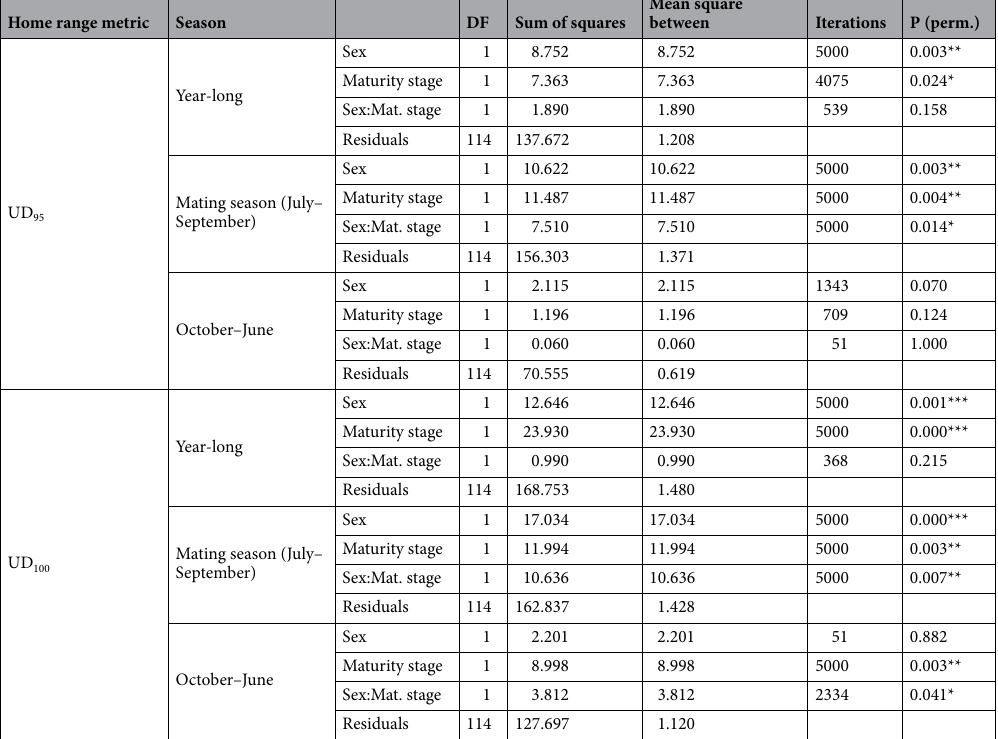
Table 1. Explaining variability in shark home range by PERMANOVA tests. Asterisks indicate p -value thresholds (***: < 0.001; **: < 0.01; *: < 0.05). Two metrics of home range (UD 95 and UD 100 ) were compared between sex (male, female) and maturity stage (adult, juvenile) at all seasons, during the mating season, and outside the mating